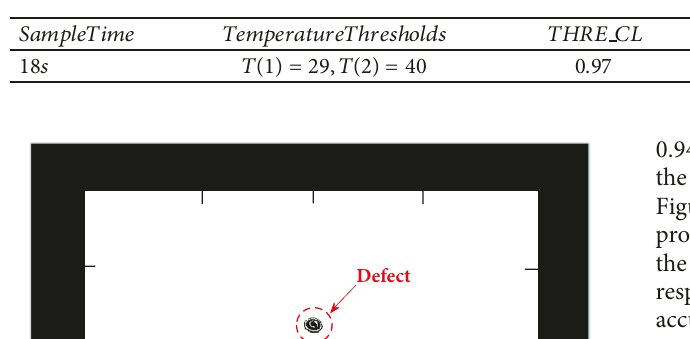
Table 2: Parameter index of specimen 2.